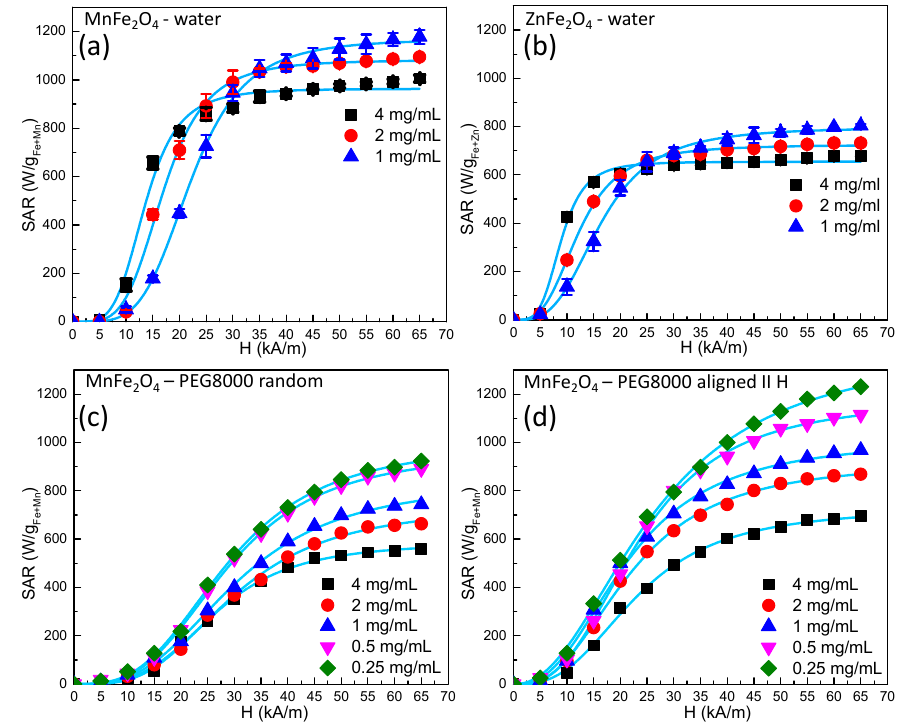
Figure 3. Specific absorption rate (SAR) dependence on the alternating magnetic field amplitude at different MNP concentrations for ( a ) manganese ferrite in water, ( b ) zinc ferrite in water, ( c ) manganese ferrite in solid polyethylene glycol 8000 (PEG 8K) with a random orientation, and ( d ) manganese ferrite in a solid PEG 8K prealigned parallel with alternating magnetic field directions.